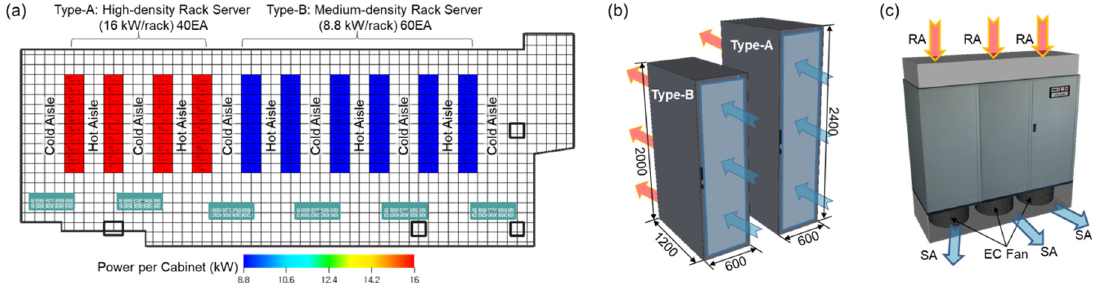
Figure 3. Basic analysis model; ( a ) server rack arrangement in IT server room, ( b ) server rack modeling and ( c ) CRAH unit modeling. and ( c ) CRAH unit modeling.